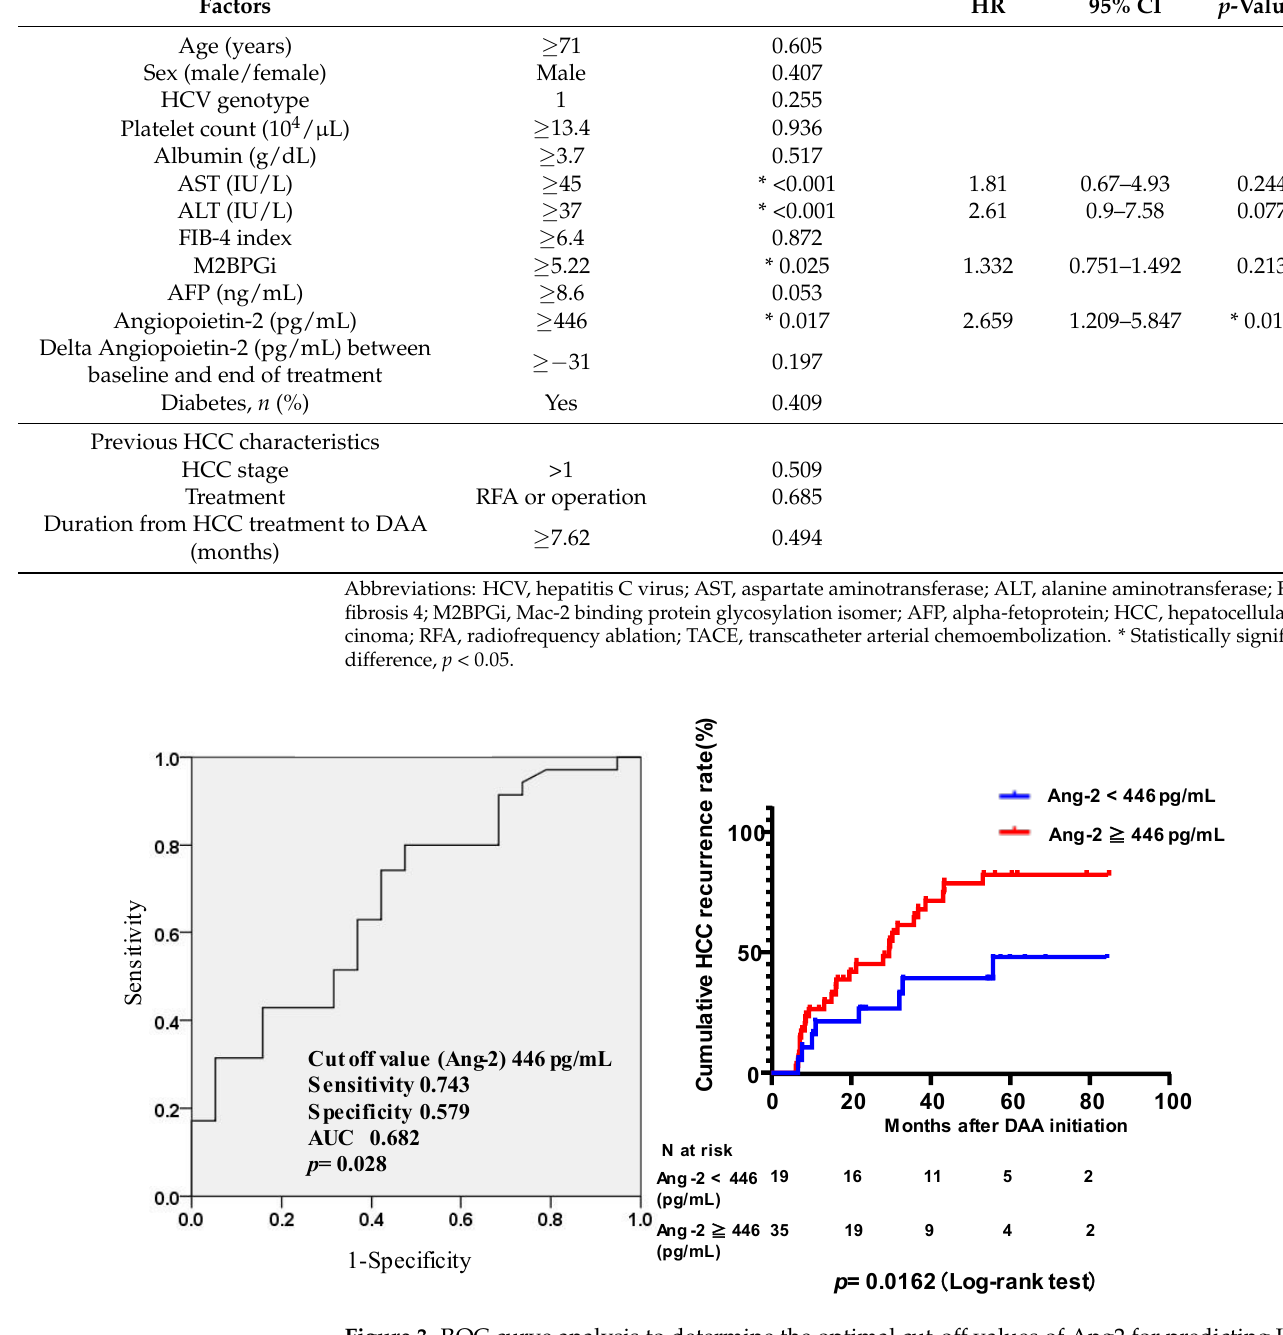
Table 4. Baseline factors associated with recurrent HCC after DAA therapy. Cut-off Value Univariate p -Values Multivariate